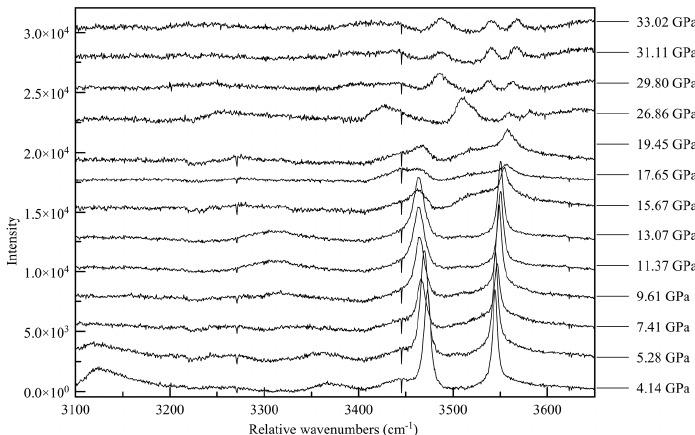
Figure 13. Raman spectra of melamine in N-H vibration region, vertical offset indicates sequential pressure steps in GPa, as shown on the right vertical axis. Intensity is arbitrary with vertical stacking offset.